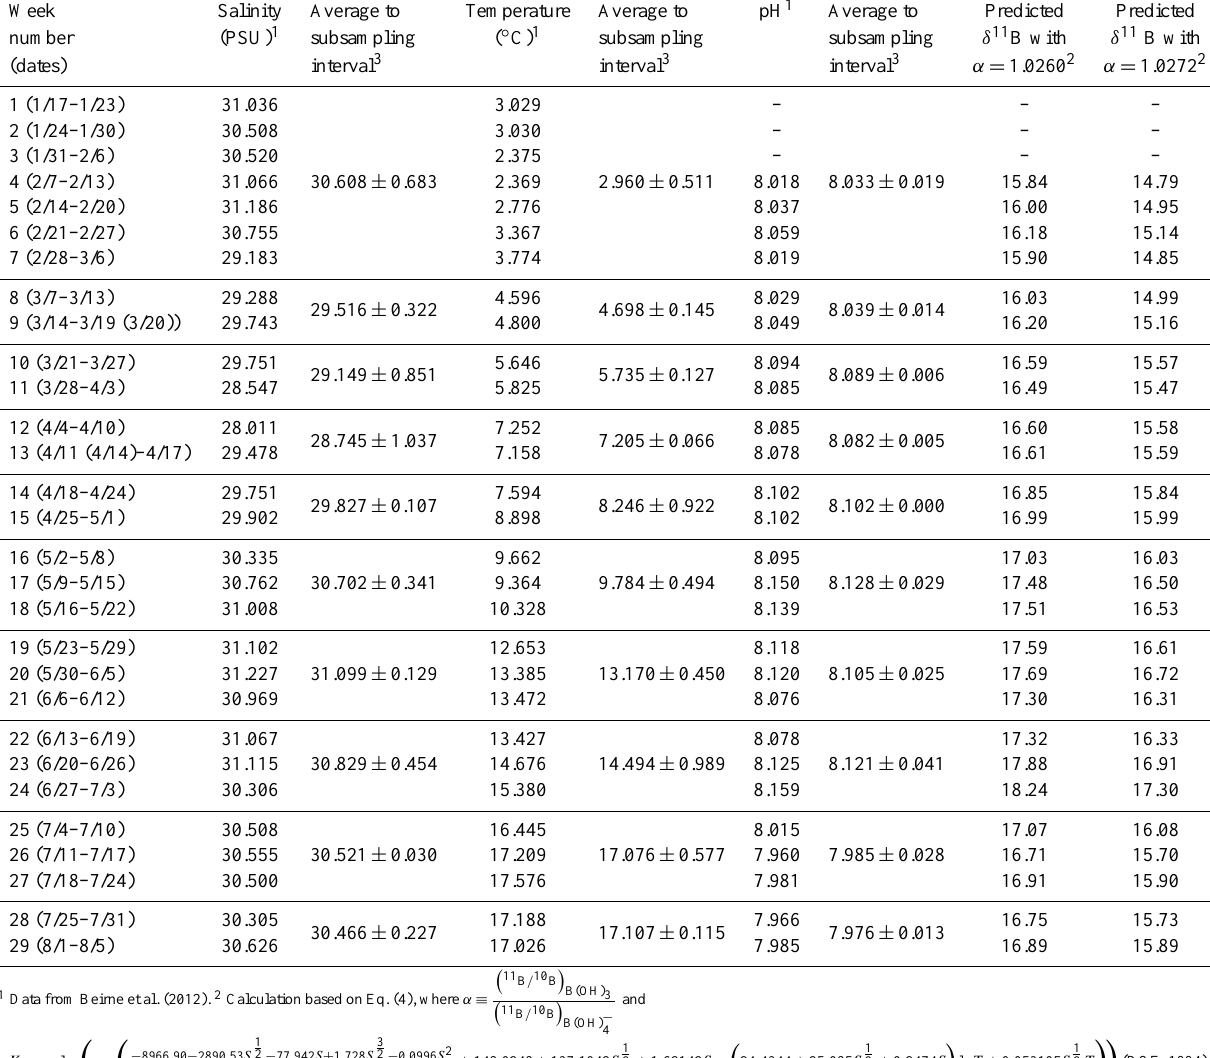
Table 1. Summary of in situ instrumental data of tank seawater salinity, temperature, and pH during culture